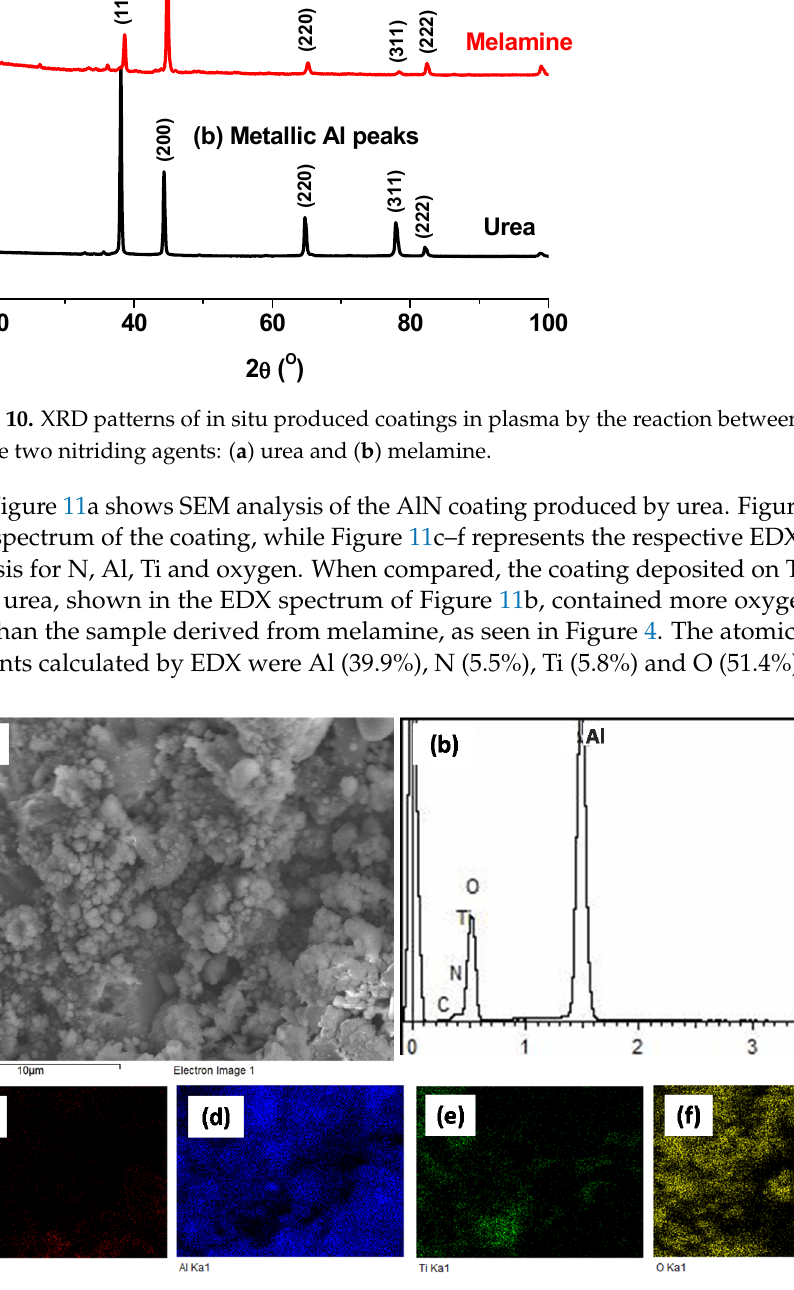
Figure 11. SEM imaging of AlN coating derived from Al and urea on Ti substrate in X5000 magnification, indicating its ( a ) secondary electron image; ( b ) EDX spectrum; and ( c – f ) EDX elemental mapping for N, Al, Ti, O, respectively.